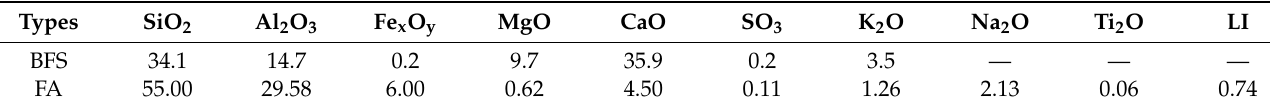
Table 2. The chemical composition of cement (%).